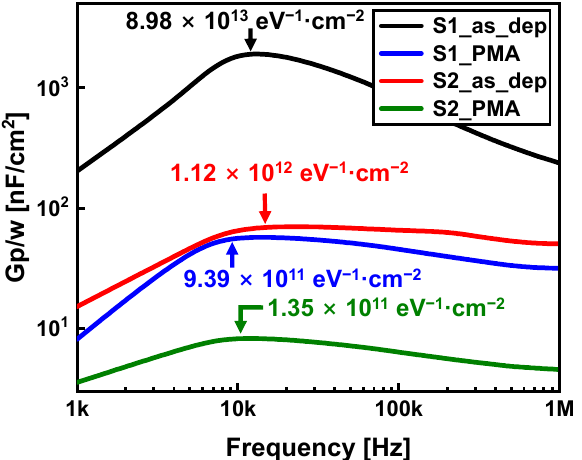
Figure 6. G P /w vs. frequency curves of Al 2 O 3 samples with and without PMA for measuring interface trap density (D it ).